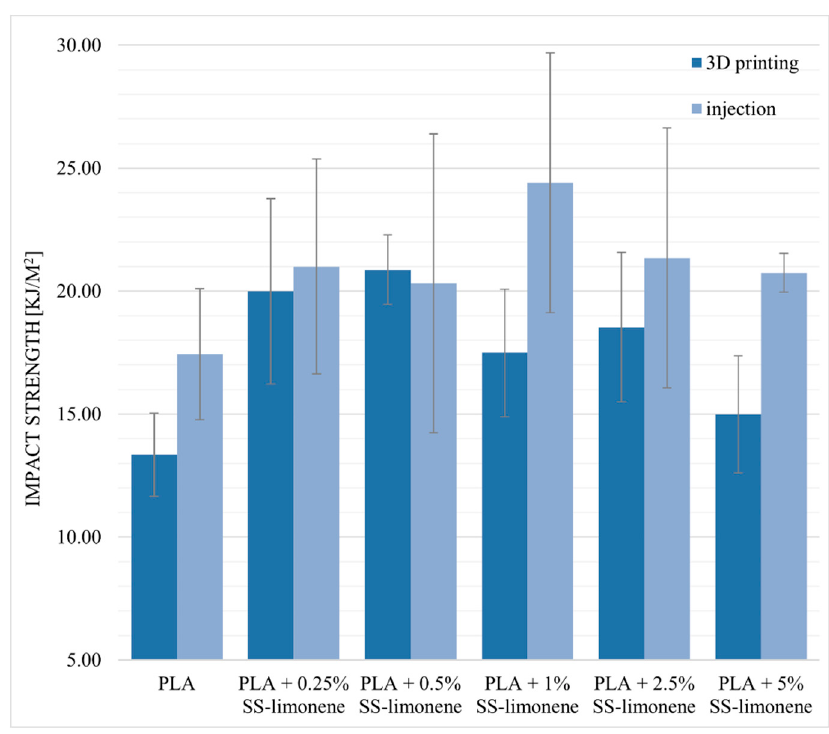
Figure 12. Impact strength of SS-Limonene/PLA in 3D printing and injection moulding.